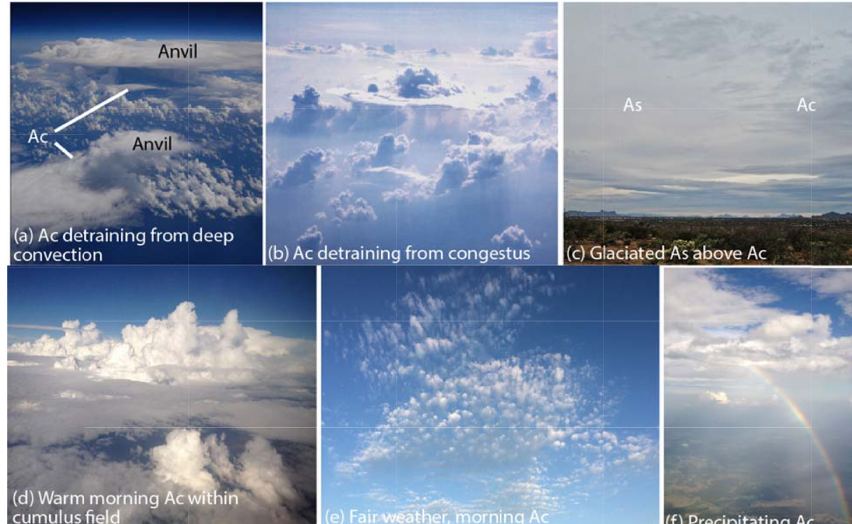
Figure 1. Cloud photographs of Ac and As characteristics. (a) Image from the NASA ER-2 showing Ac shelf clouds detraining from deep convection over the Gulf of Mexico during SEAC 4 RS; (b) Ac detraining from Cumulus congestus in a field of biomass burning smoke over Brazil (Reid et al., 1999); (c) mixed field of As above Ac clouds during a convectively active period in Arizona; (d) warm Ac clouds over developing cumulus field over west Texas during SEAC 4 RS ; (e) morning fair weather Ac field over Monterey, CA; (f) precipitating thin Ac clouds over central Texas during SEAC 4 RS. (Photo credit: (a) Donald S. Broce, NASA; (b, c) Arthur L. Rangno, enhanced for contrast; (d–f) : Jeffrey S.